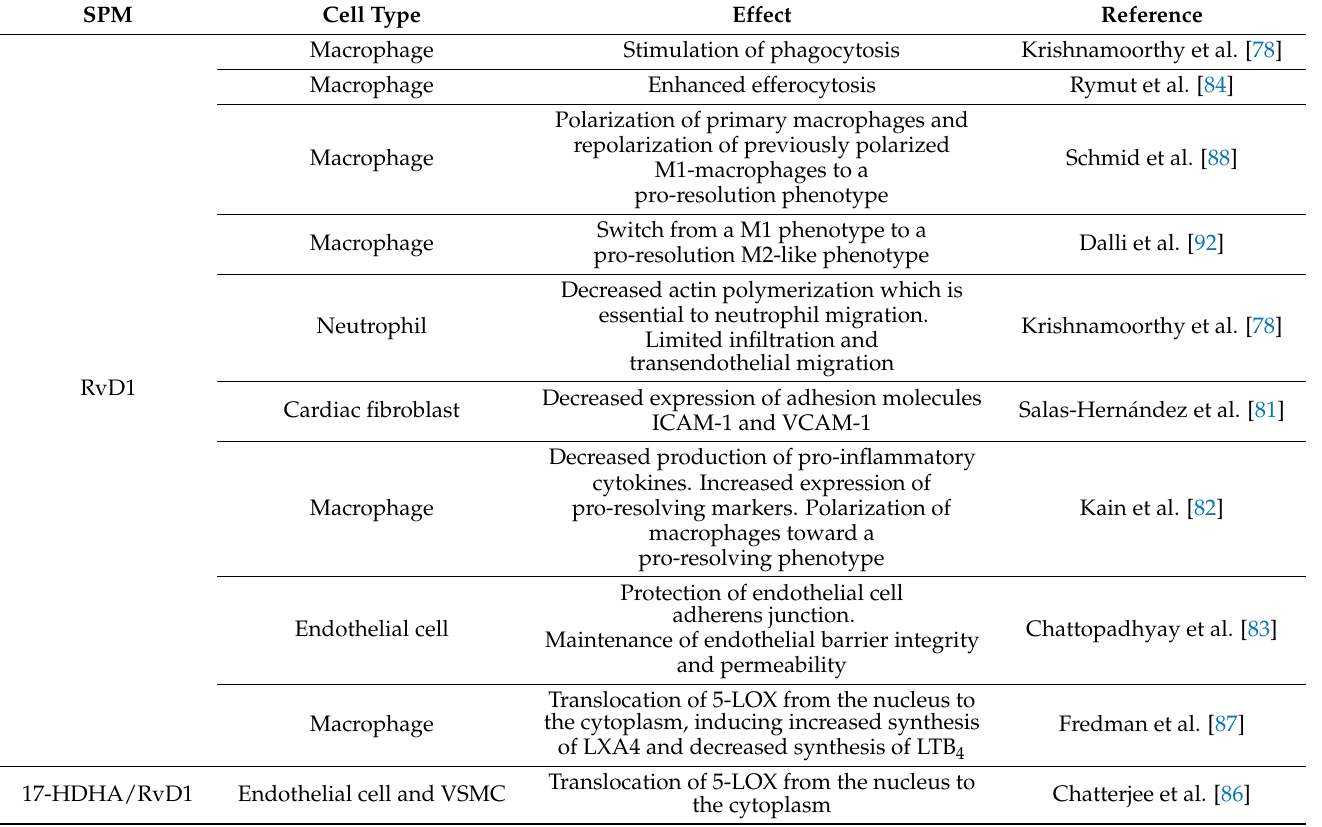
Table 1. Effects of SPMs on various cell